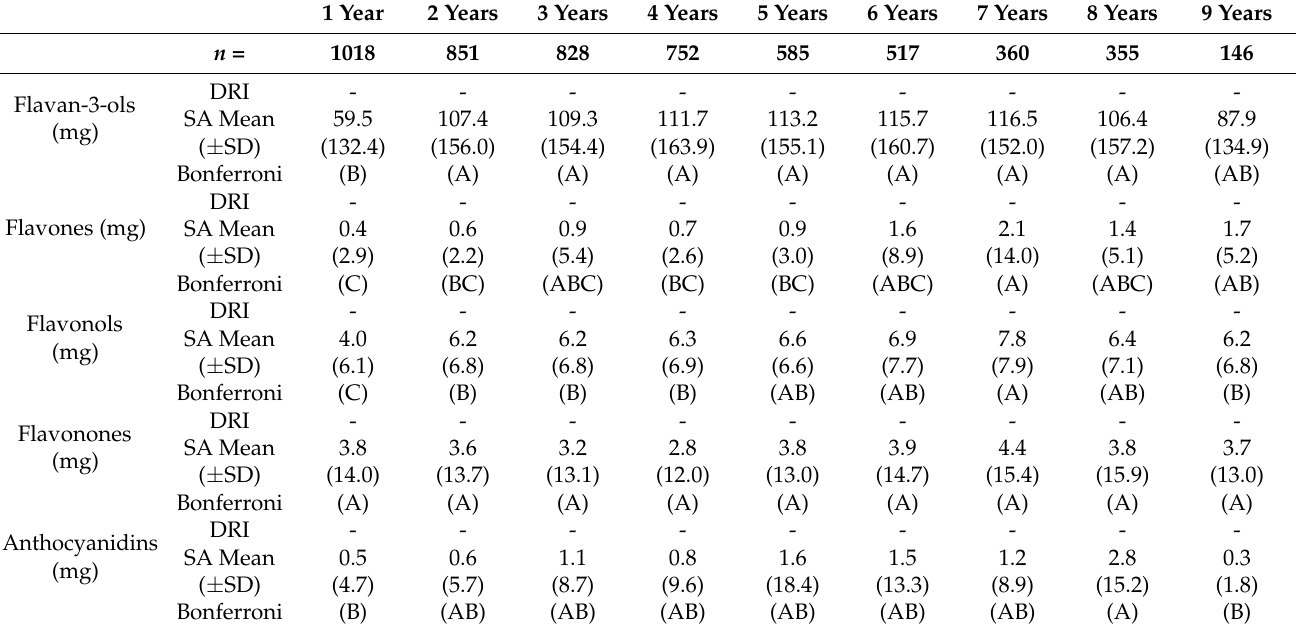
Table 6. South African child mean ± SD intake of flavonoids and other food parameters by year of